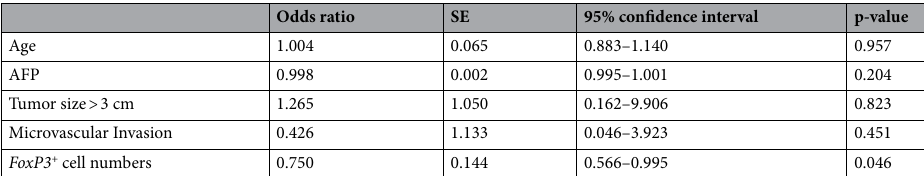
Odds ratio SE 95% confidence interval